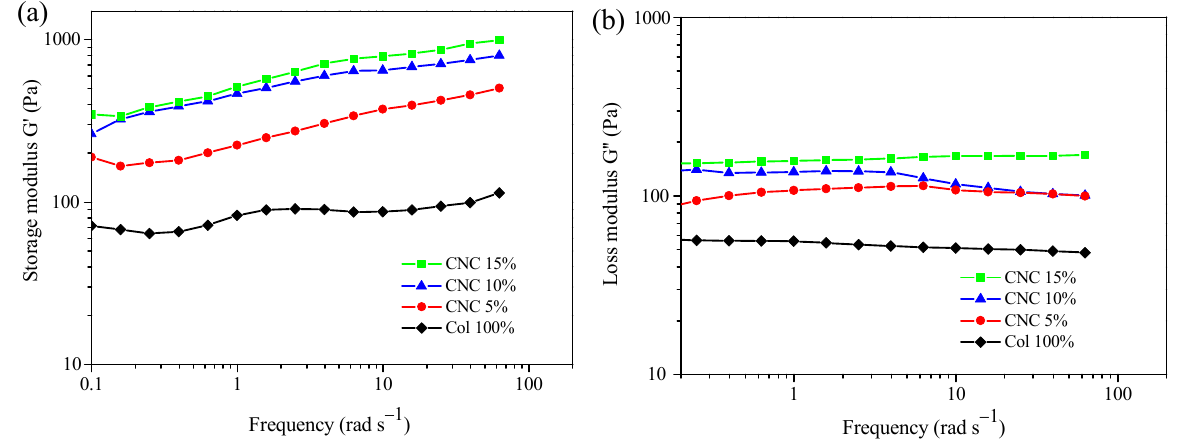
Figure 8. Frequency dependence of G ′ ( a ) and G ″ ( b ) of CNC/Col hydrogels.